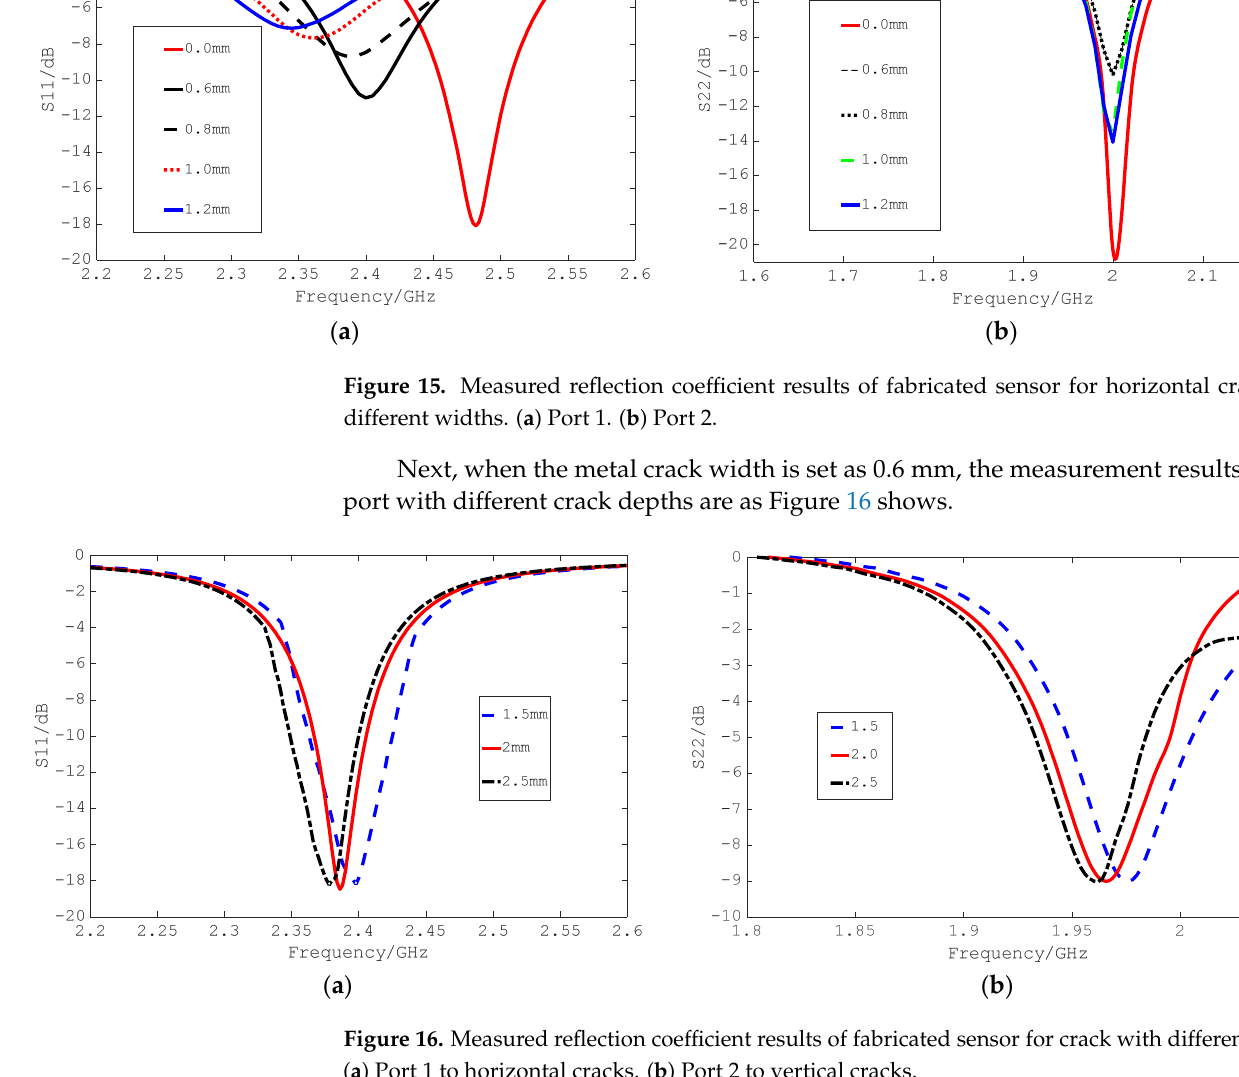
Figure 14. Measured reflection coefficient results of fabricated sensor for vertical crack with differ- ent widths. ( a ) Port 1. ( b ) Port 2.